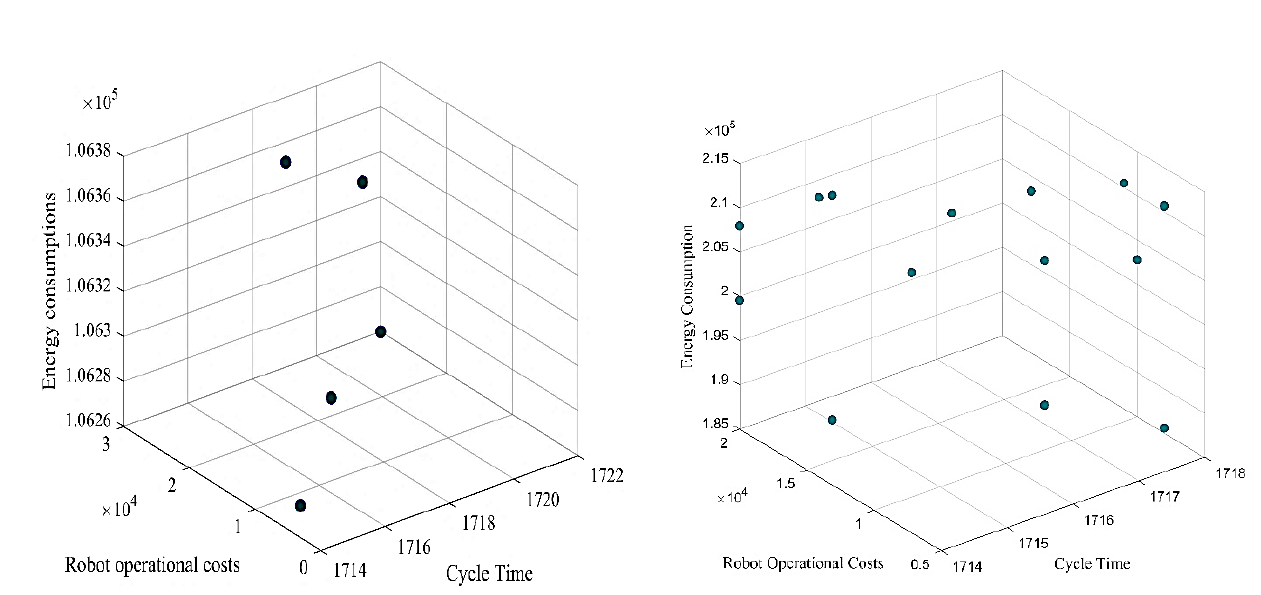
Figure 4. Operational optimal solutions of goal